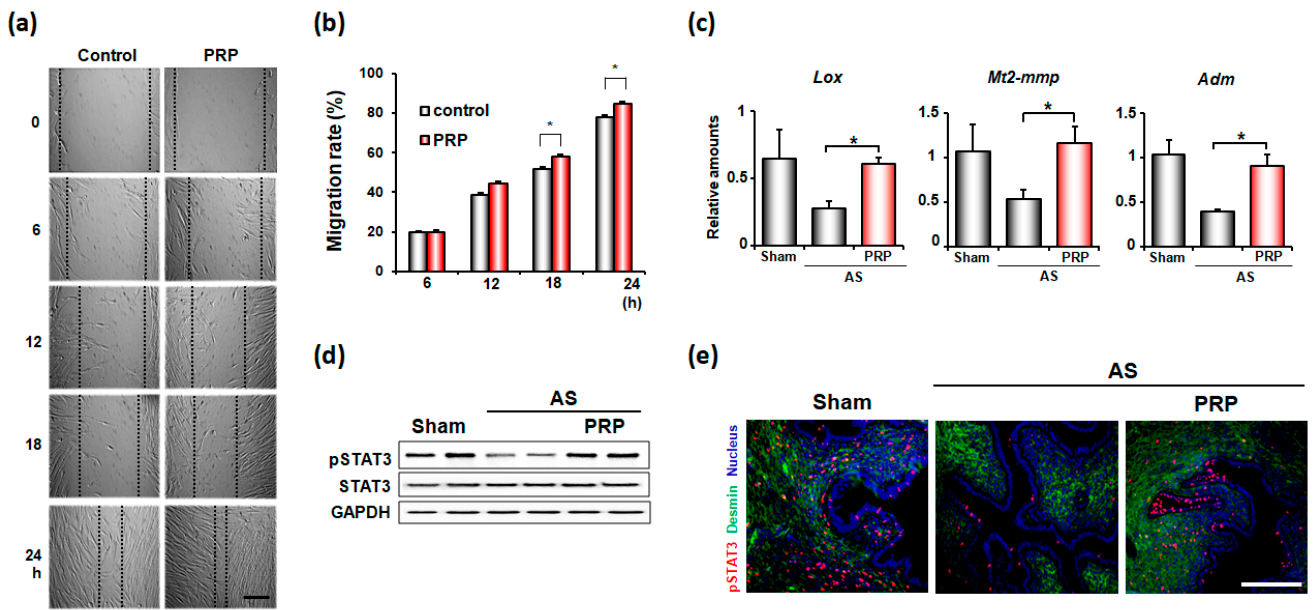
Figure 6. PRP promotes cell migration for endometrial remodeling in mice with AS. ( a ) Representative microscopic images of wound-healing assays with human endometrial stromal cells with or without hPRP for 24 h. Scale bar, 100 µ m ( b ) The graphs for migration rates of endometrial stromal cells in ( a ). * p < 0.05. ( c ) Realtime-RT PCR results of tissue remodeling factors in the uterus with AS after hPRP treatment. ( d , e ) Western blotting ( d ) and immunofluorescence staining ( e ) of phosphorylated STAT3 (pSTAT3) in the uterus with AS after hPRP treatment. Red and blue colors indicate pSTAT3 and nucleus, respectively. Scale bar, 50 μ m.